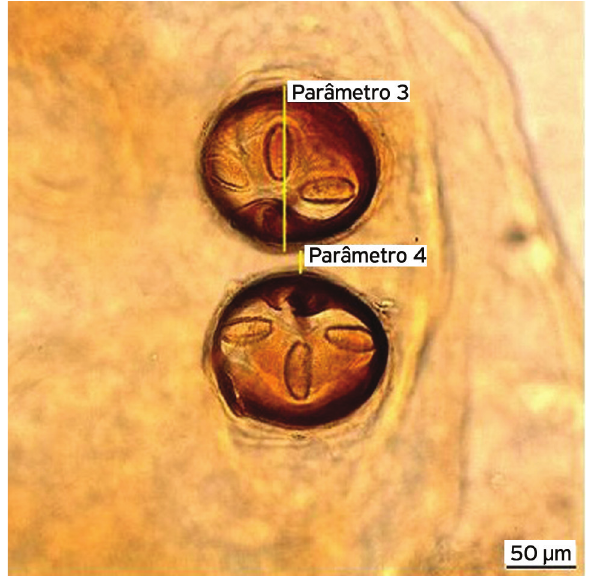
Figura 2. Parâmetros utilizados na morfometria das estruturas anteriores e posteriores das larvas de Neosilba perezi: 3. Diâmetro do espiráculo posterior direito em vista dorsal; 4. Distância entre os espiráculos posteriores em vista